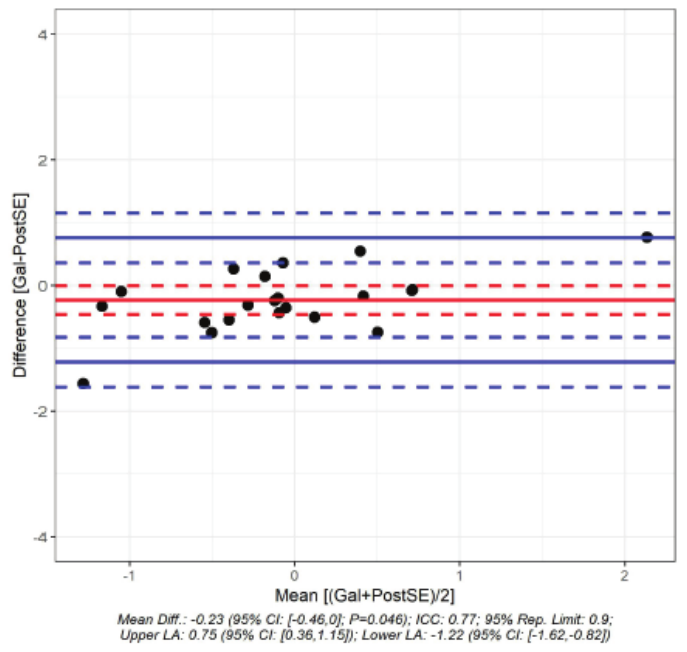
Figure 2. Bland–Altman Plot to visualize the difference of the G6 theoretical calculation post OP SE if lens calculated with G6.